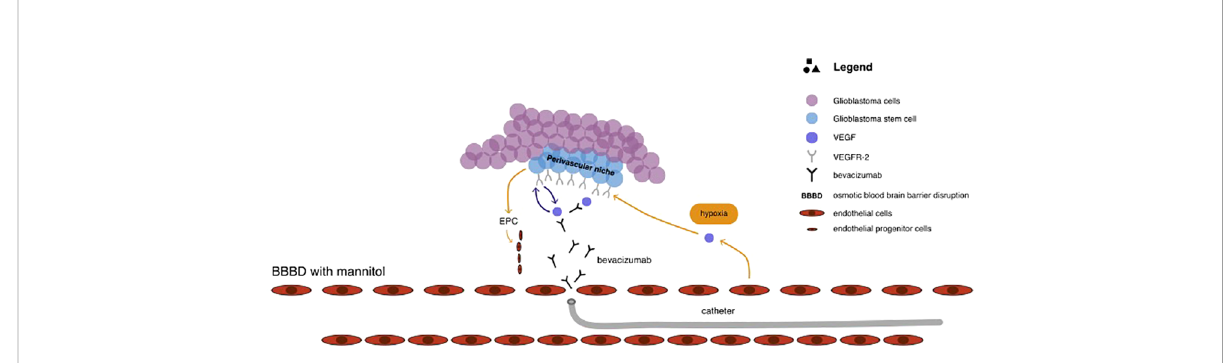
FIGURE 3 The pharmacological mechanism of catheter delivered bevacizumab in the treatment of